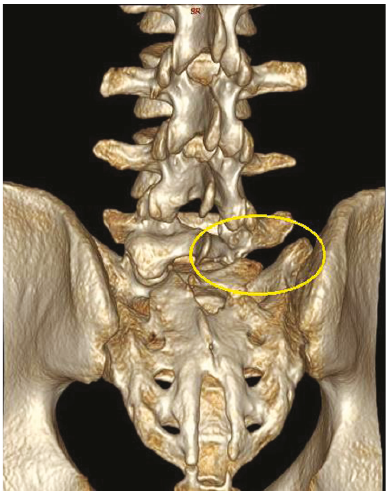
Figure 3: CT scan 3D reconstruction shows agenesis of the L5 inferior articular process on the right side with no other related bony abnormalities identi fi